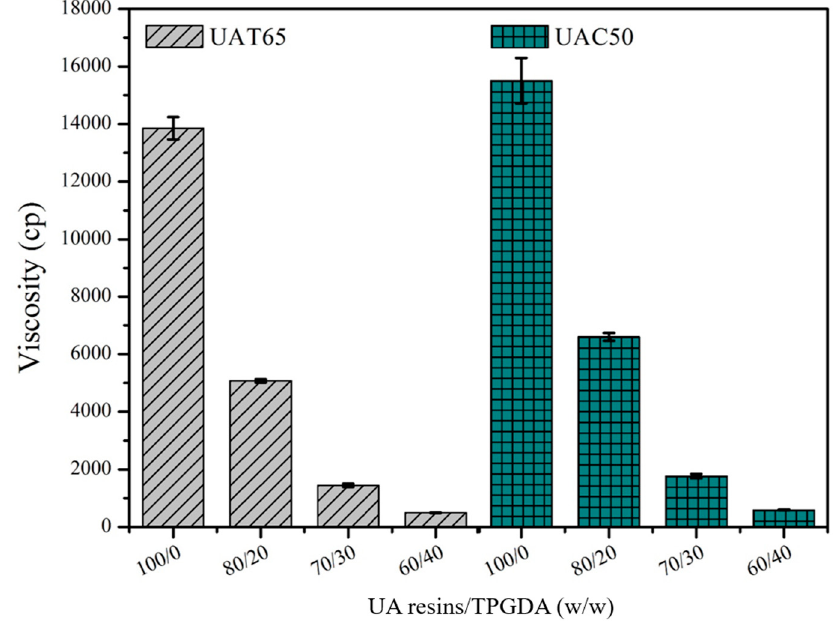
Figure8. ViscosityanalysisofUAresinswithvariousweightratiosofUAT65 / TPGDAorUAC50 / TPGDA Figure 8. Viscosity analysis of UA resins with various weight ratios of UAT65/TPGDA or according to ISO UAC50/TPGDA according to ISO 4049:2009.